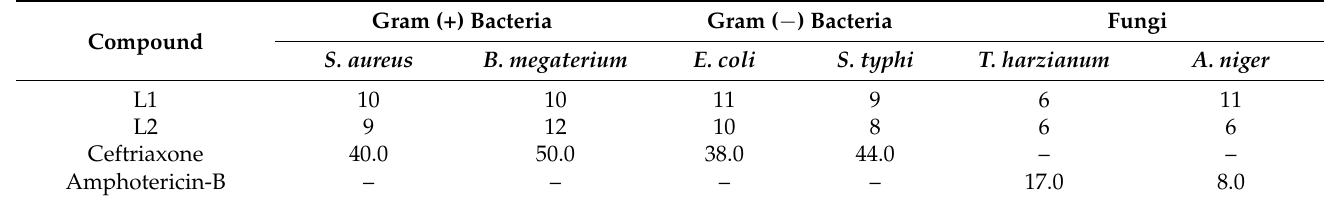
Table 5. Diameter of inhibition zones (mm) of the synthesized compounds, ceftriaxone and amphotericin-B against tested bacterial and fungal